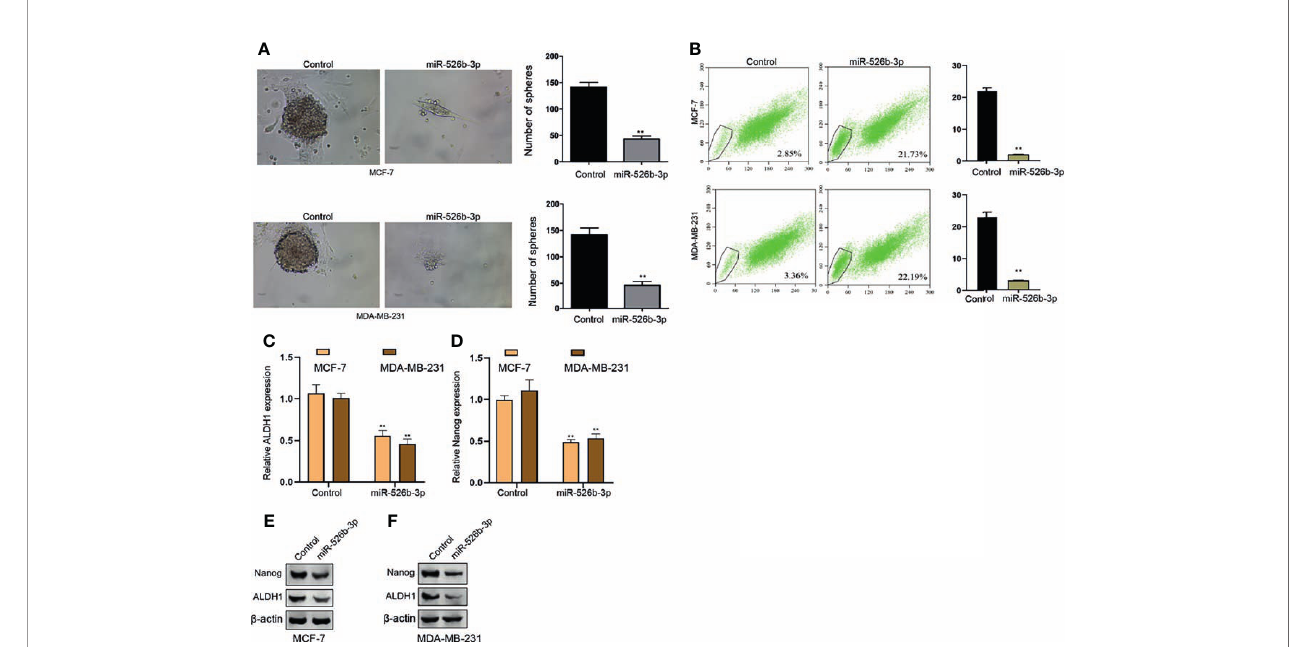
FIGURE 5 | MiR-526b-3p suppresses CSCs properties of breast cancer cells in vitro . (A – F) The MCF-7 and MDA-MB-231 cells were transfected with miR-526b-3p mimic. (A) Stemness of MCF-7 and MDA-MB-231 cells was analyzed by sphere formation assays. (B) The SP ratio of MCF-7 and MDA-MB-231 cells was measured by fl ow cytometry analysis of Hoechst 33342 staining. (C, D) The mRNA expression of ALDH1 and Nanog was measured by qPCR. (E, F) The protein expression of ALDH1 and Nanog was detected by Western blot. Data are mean ± SD: ** p < 0.01.